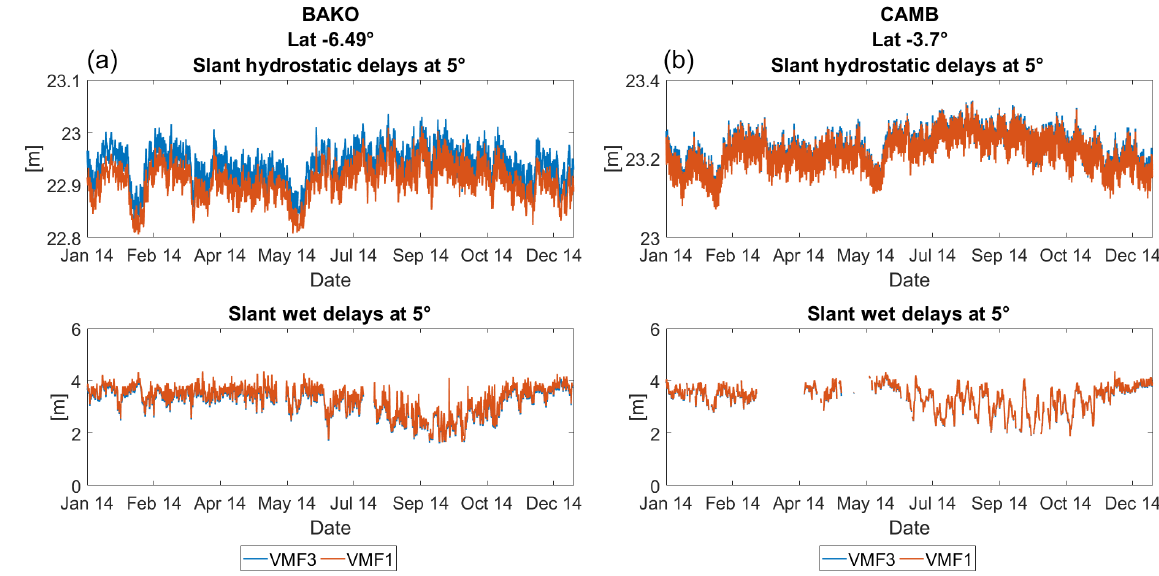
Figure 9. Slant hydrostatic and wet delays at 5 ◦ from VMF3 and VMF1 at sites BAKO and CAMB.